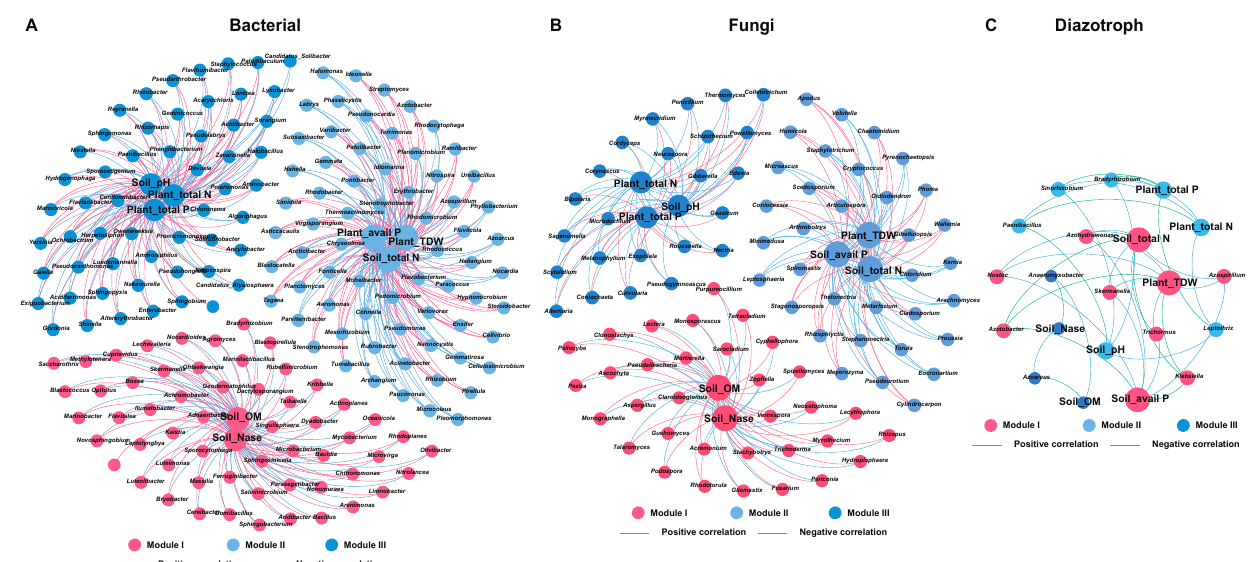
Figure 13. Co-occurrence network of environment–biology, representing the correlations between the environment factors and the relative abundances of the bacteria ( A ), fungi ( B ) and diazotrophs ( C ). The connections are Spearman correlations with significance ( p < 0.05) and high significance (0.6 < |r| < 1, red line: positive correlation, blue line: negative correlation). The network is color coded by module, which means that the nodes clustered in the same module share the same color.